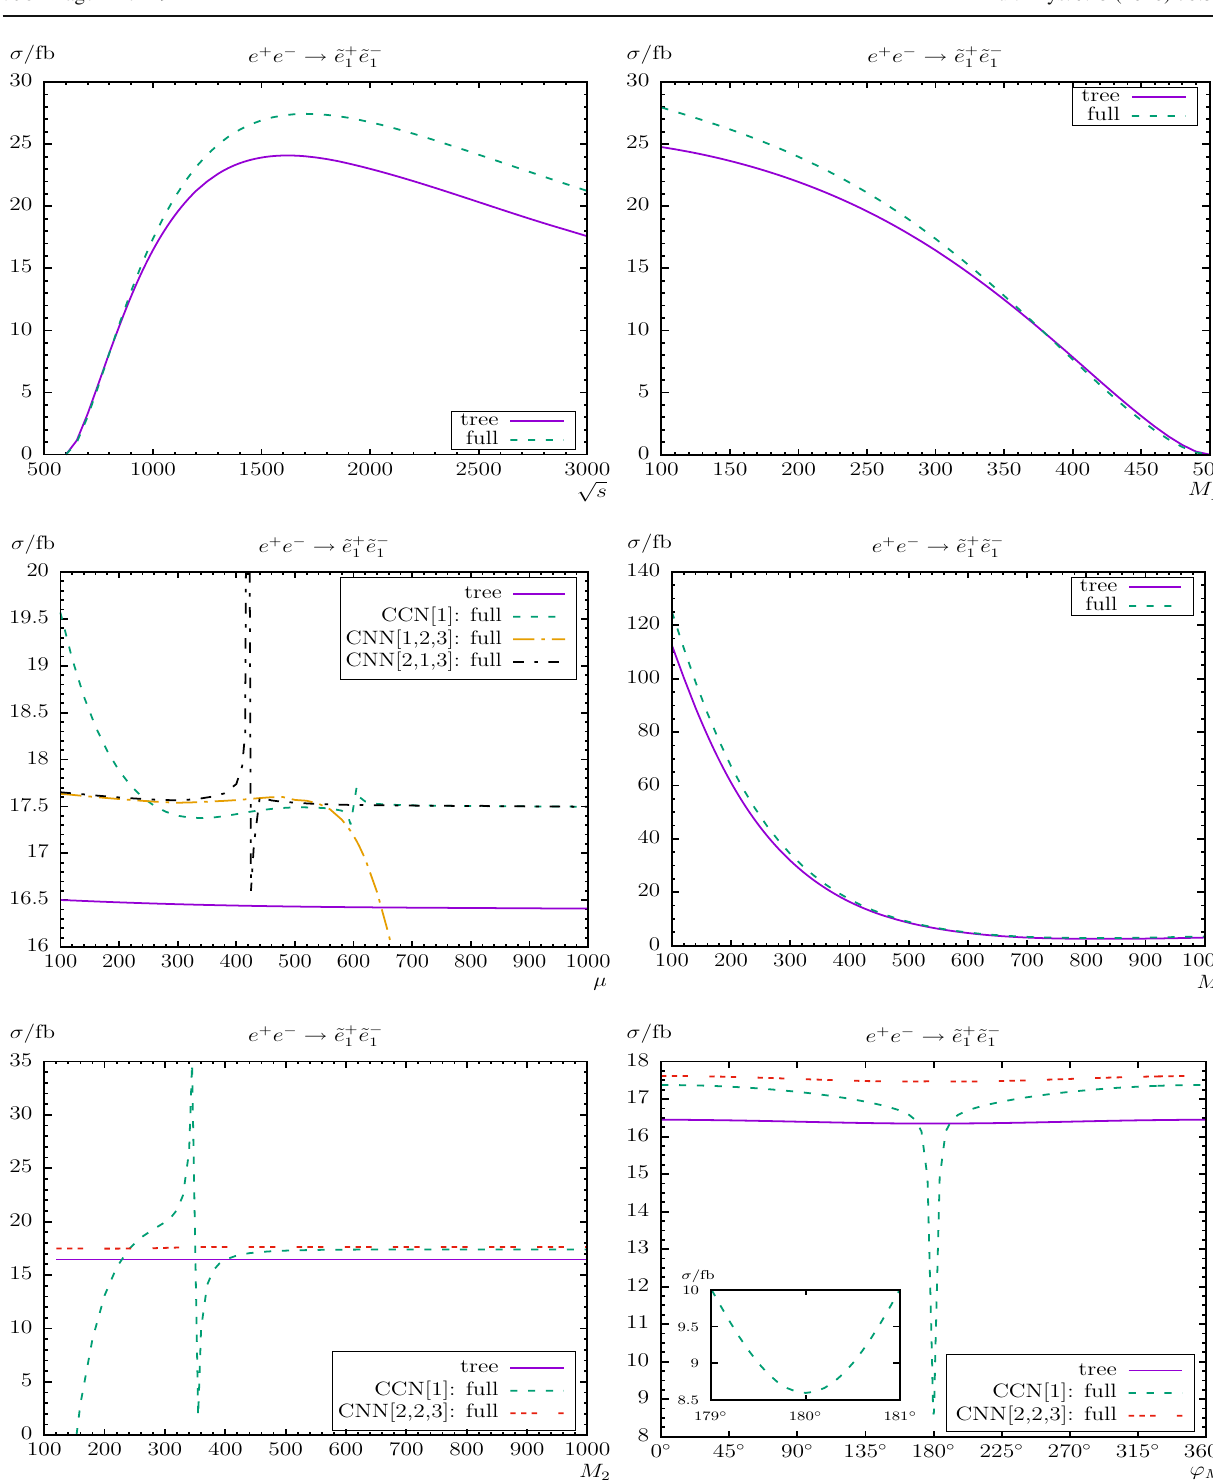
(right) varied. All masses and energies 1